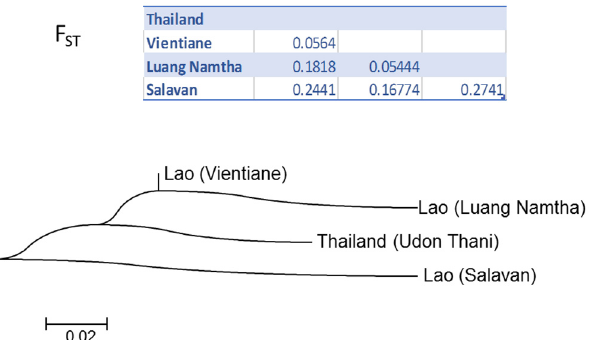
Fig 5. Population differentiation (F ST ) based on concatenated sequences. Populations were defined according to four strain sources; three from Laos (Vientiane, Luang Namtha and Salavan) characterised in the current study, and one population from Thailand (Udon Thani) characterised previously. The F ST values are depicted as a dendrogram using the neighbour-joining algorithm.